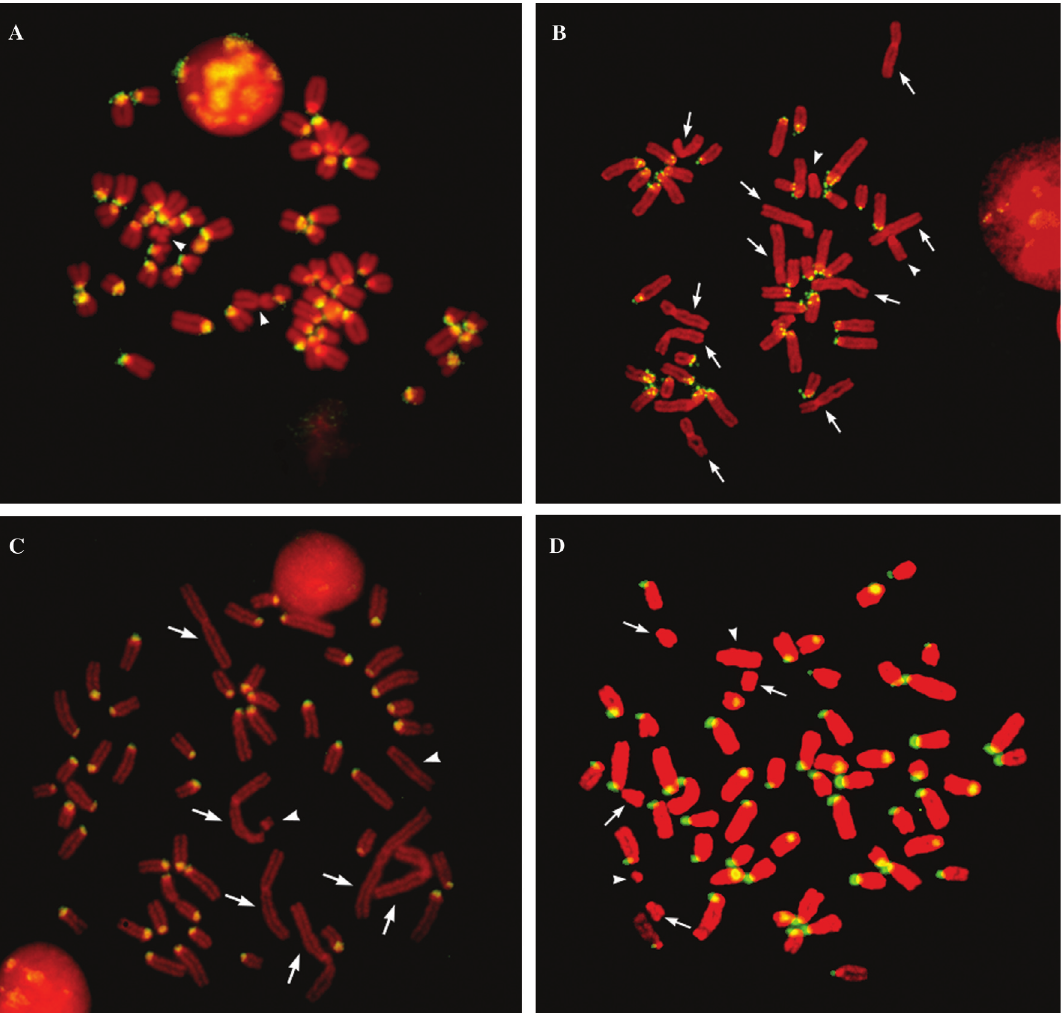
Figure 3 - Fluorescence in situ hybridization. A) Chromosomes from Bos taurus hybridized to probe Bt1. Signals are present in pericentromeric regions ofeveryautosome,butnotontheXandYchromosomes(indicatedbyarrowheads).B)Chromosomesfrom Bubalusbubalis hybridizedtoprobeBt1.Sig- nals are present in pericentromeric regions of acrocentric autosomes, but not on the five pairs of bi-armed autosomes (arrows), or on the X chromosomes (arrowheads).C)Chromosomesfrom Ovisorientalismusimon hybridizedtoprobeOm1.Signalsaredetectedonallacrocentricautosomes.Nosignalwas detected on the three pairs of bi-armed autosomes (arrows), or on the X and Y chromosomes (arrowheads). D) Chromosomes from Capra hircus hybrid- izedtoprobeOm1.Signalsaredetectedonacrocentricautosomes,withtheexceptionoftwopairsofautosomes(arrows).NosignalisvisibleontheXand Y chromosomes